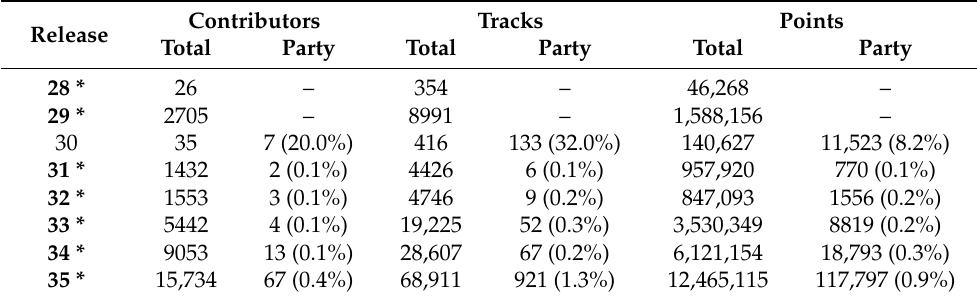
Table 2. Distribution of collected data per release, from 29 August 2017 to 28 August 2020. The number of collected data during NoiseCapture Parties (see Section 3.6) is also indicated, as well as in terms of percentage of the total number of data. Releases in bold with symbol * correspond to public releases on Google Play. Note that the total number of contributors in this table (74,082) does not correspond to the total of unique contributors, as a contributor may have use several release of the